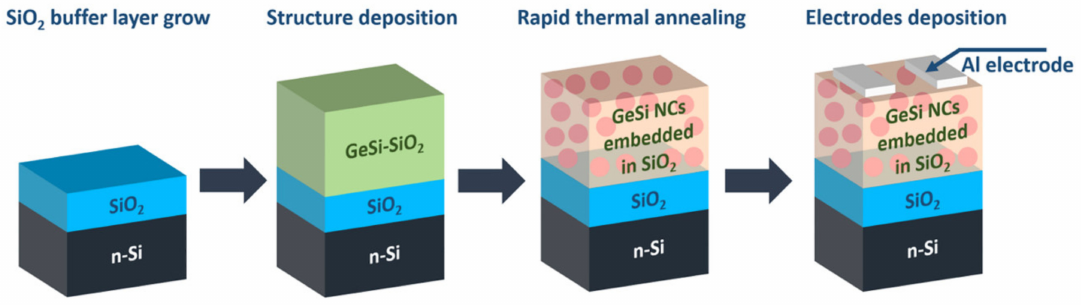
Figure 1. The workflow for obtaining the GeSi NCs:SiO 2 / SiO 2 / n-Si